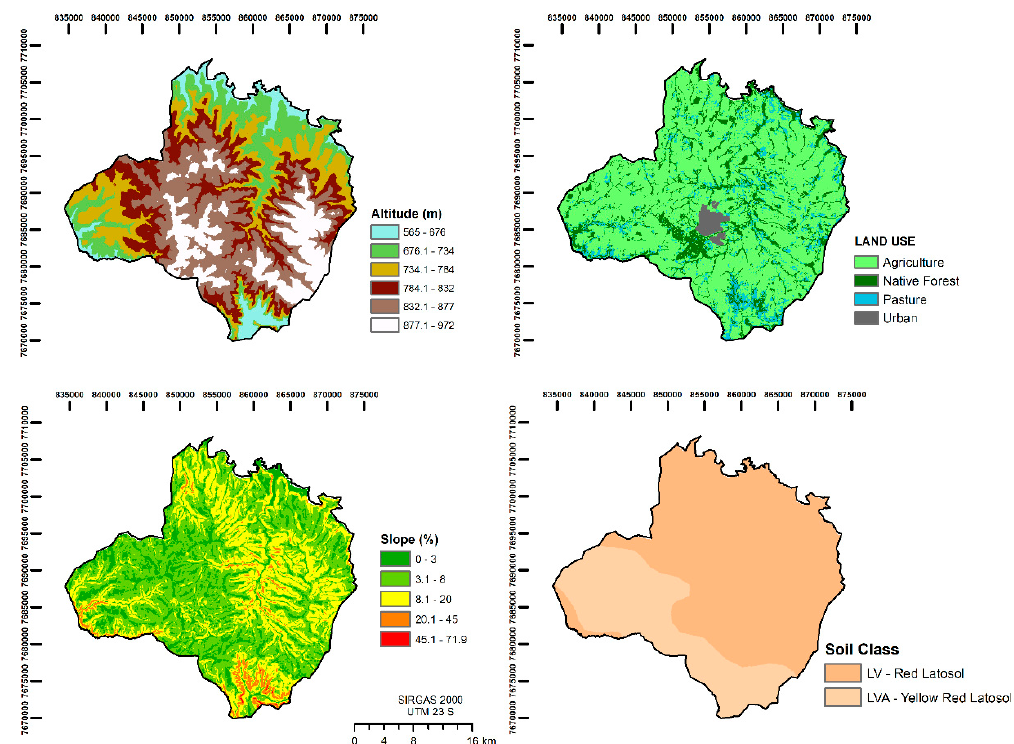
Figure 4. Maps of environmental attributes within the municipality of Batatais SP.